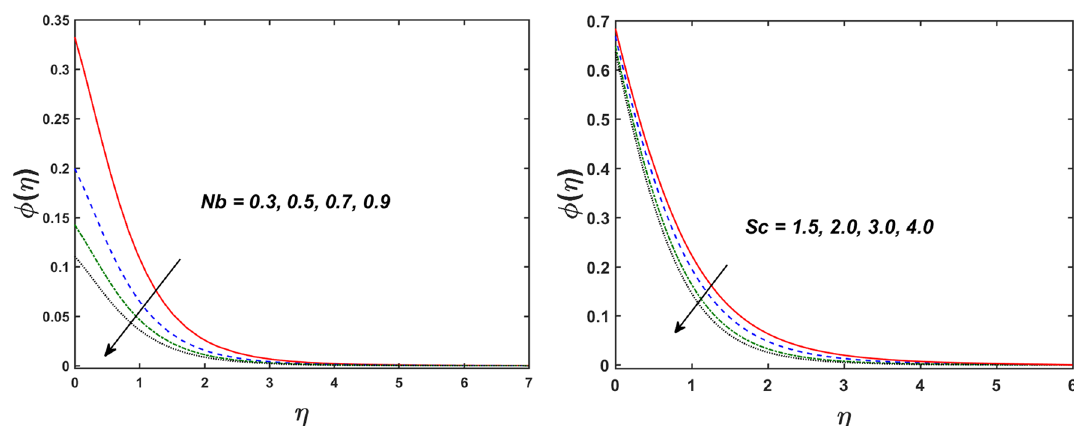
Figure 9. Variation in φ(η) for Nb and Sc .